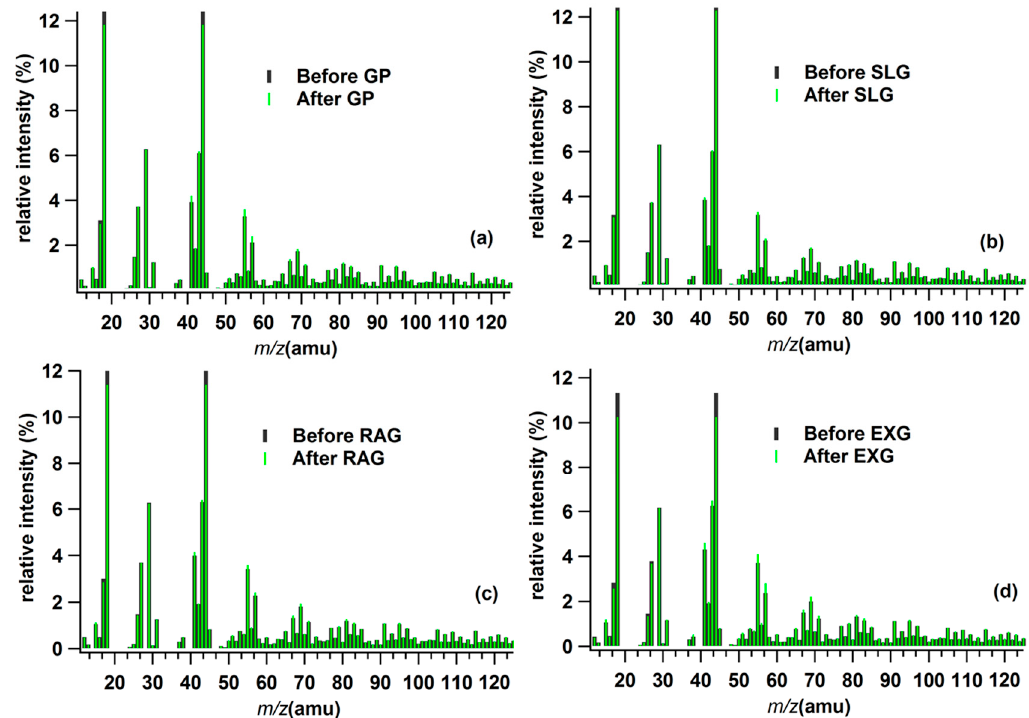
Figure 10. Mass spectra of average OA before and after GP ( a ), SLG ( b ), RAG ( c ), and EXG ( d ). Secondary aerosol (SPM = SO 42 − + NO 3 − + NH 4+ +OOA) is the most important